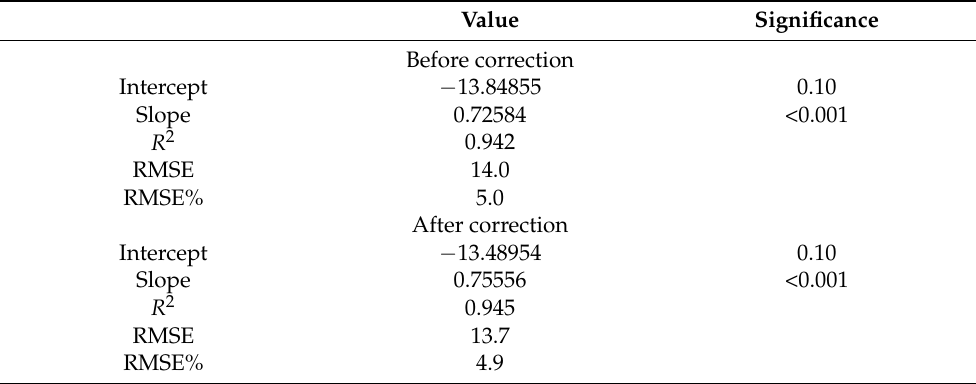
Figure 6. C ontents of total OHTyr determined by HPLC after hydrolysis of the extracts plotted versus the contents of total OHTyr determined by NADES extraction and UV analysis. The red dotted line has the function y = x, the red solid line is the fitted regression. The panel on the left ( A ) plots the values of total OHTyr determined prior the correction of the second derivative of absorbance at 299 nm, while the panel on the right ( B ) plots the values obtained after the correction (please see text for details on the correction procedure). Table 3. Parameters of the regression analysis of total OHTyr determined by NADES-UV, versus total OHTyr determined by acid hydrolysis and HPLC.